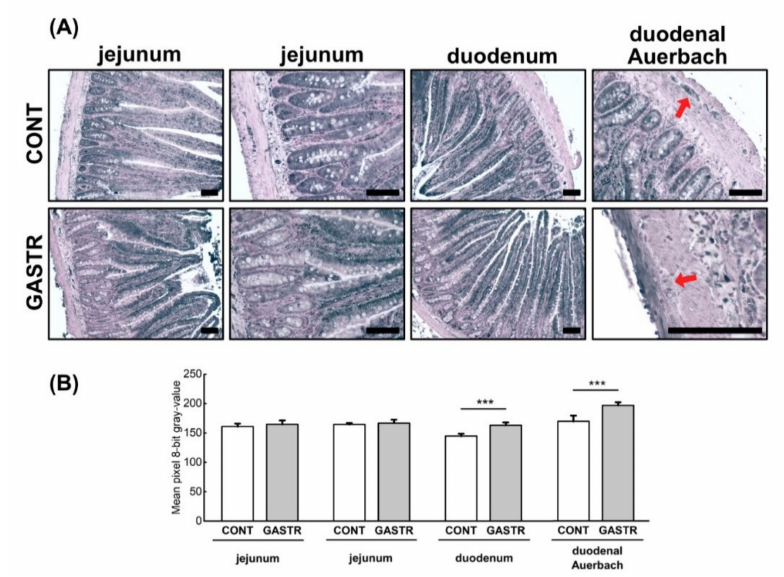
Figure 10. ( A ) Representative photomicrographs of the immunohistochemical reactions for leptin in the jejunum, duodenum and duodenal Auerbach plexus (red arrow). Sections were developed in 3,3 (cid:48) -diaminobenzidine tetrahydrochloride with metal enhancer; counterstaining was performed with Nuclear Fast Red. All the scale bars represent 100 µ m. ( B ) The intensity of expression of ghrelin, measured by the comparison of the pixel brightness values in the microscopic images converted to 8-bit grayscale. Scale from 0 (white pixel) to 255 (black pixel); the lower the pixel value, the higher the intensity of immunohistochemical reaction. Graph shows mean ± standard error. Significance was established using a two-tailed Student’s t -test (normally distributed data), Welch’s test (normally distributed data with unequal variances) or the Mann–Whitney test (for pairwise comparisons with at least one non-normally distributed dataset); *** p < 0.001.